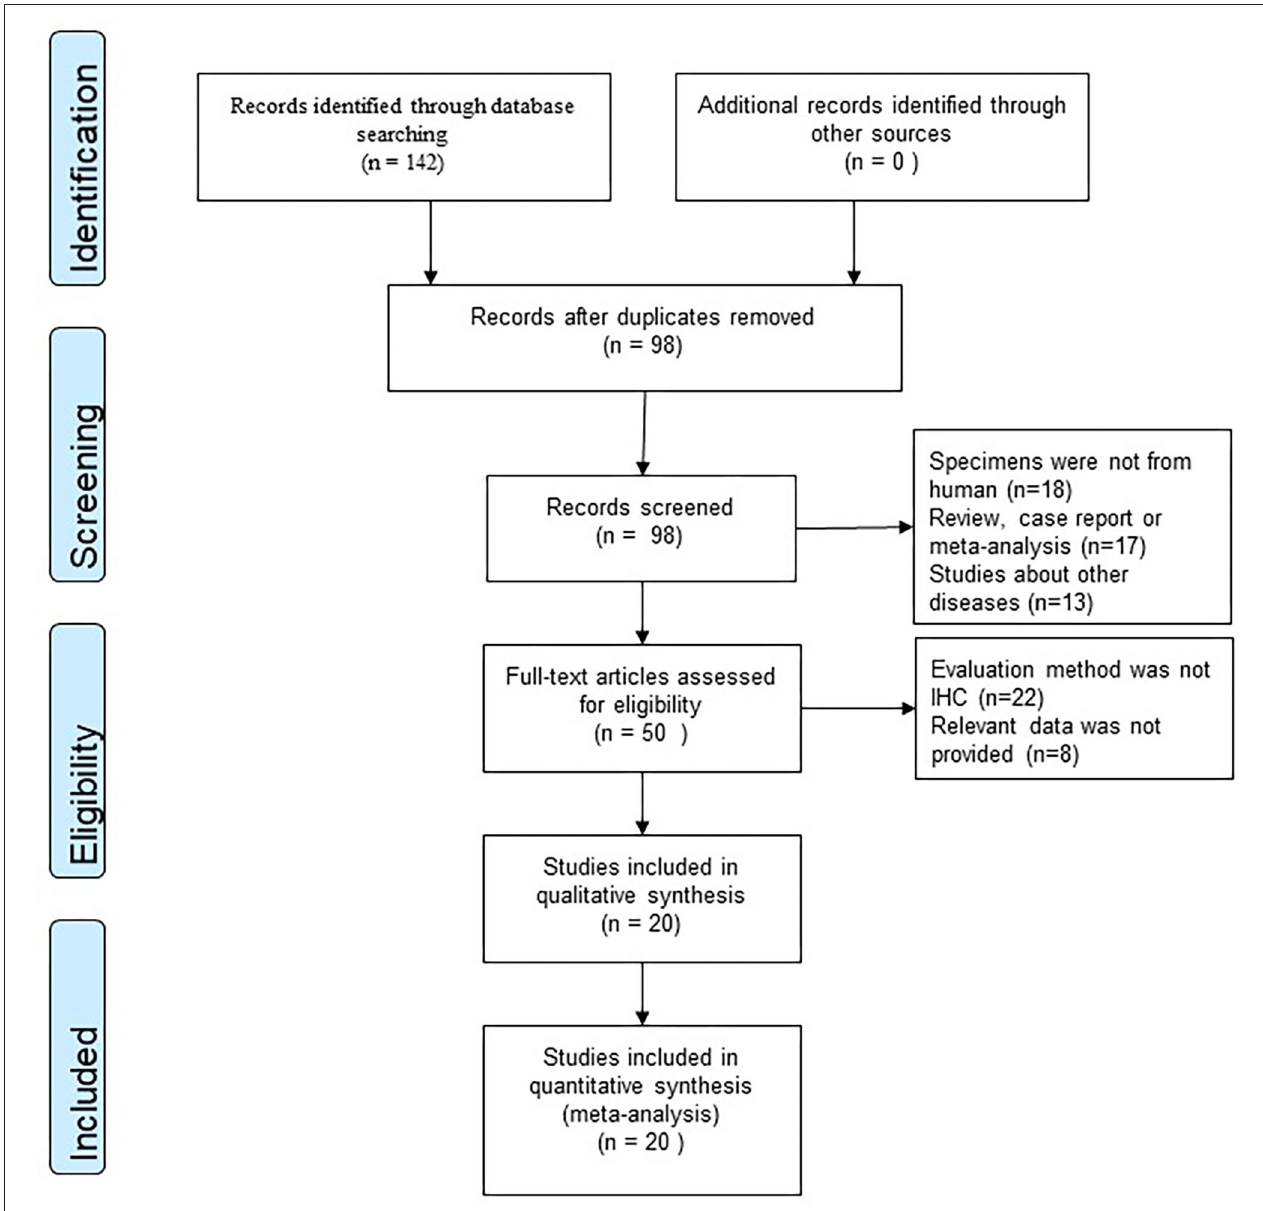
FIGURE 1 | Flow diagram of the study selection procedure of the